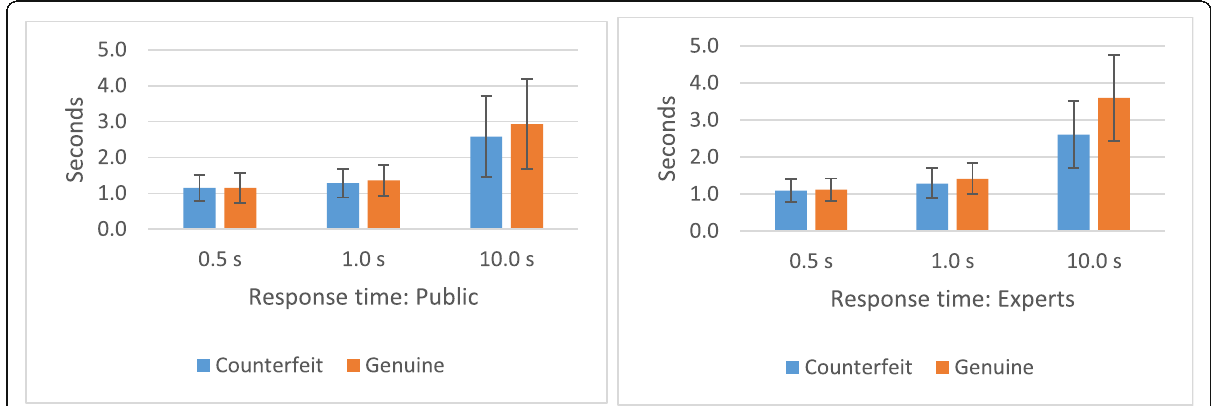
Fig. 6 Mean response time and their error bars (standard deviation (SD)) public (left) and experts (right): screen conditions